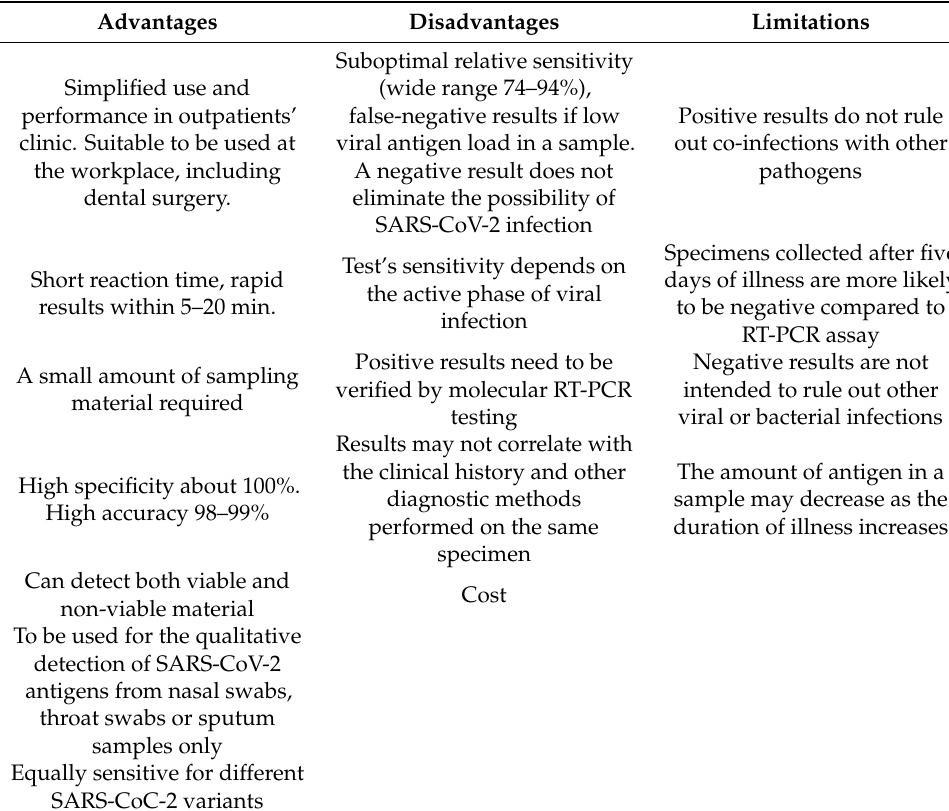
Table 1. The main advantages and disadvantages of rapid lateral flow antigen